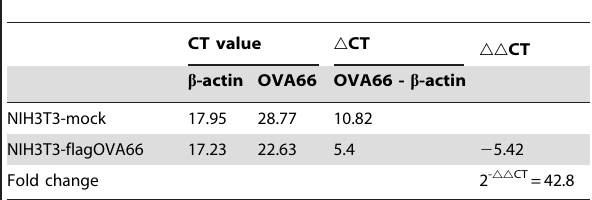
Table 1. Real-time PCR amplification of OVA66 gene showed OVA66 expression in NIH3T3-flagOVA66 cells increased by greater than 42-fold compared with NIH3T3-mock